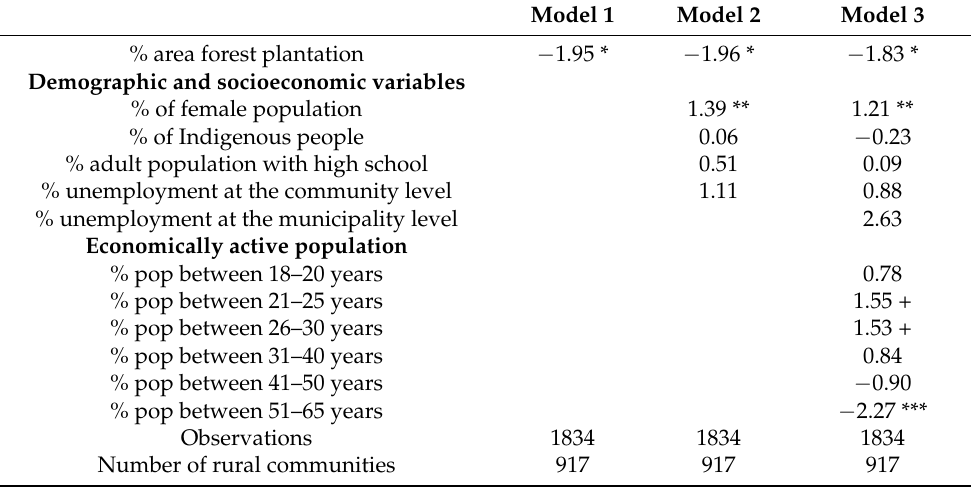
Table 2. Fixed effects regression model of the impact of expansion of forestry industry on the decline of rural population in the Araucan í a